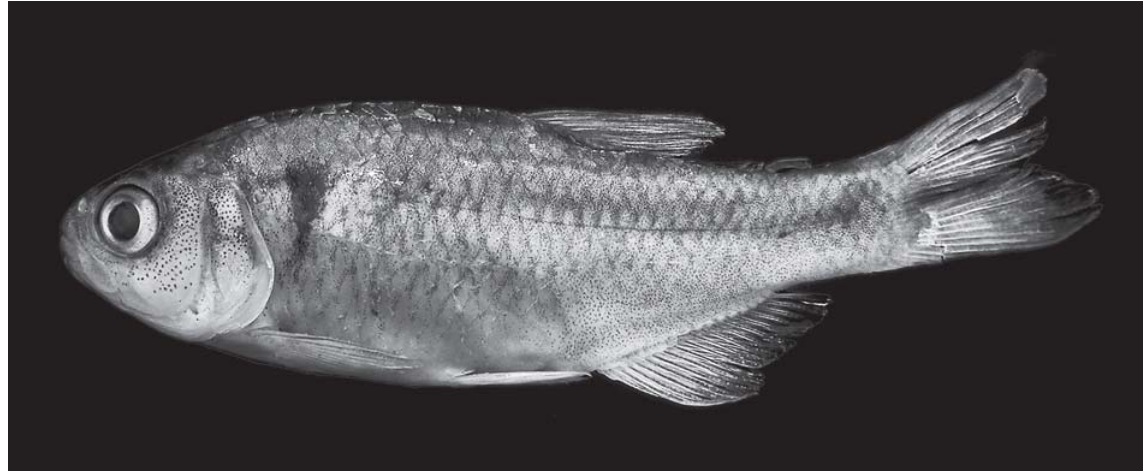
Fig. 1. Hyphessobrycon hamatus , MCP 34000, holotype, male, 43.1 mm SL; Brazil, Goiás, Mambaí, córrego Cana Brava, tributary of rio